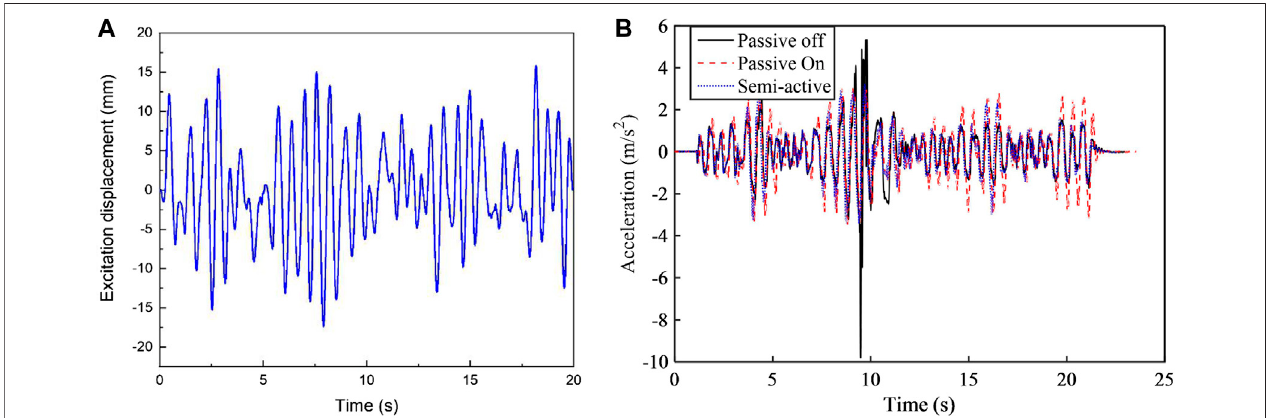
FIGURE 15 | Acceleration performance of the random excitation. (A) excitation, (B) response.